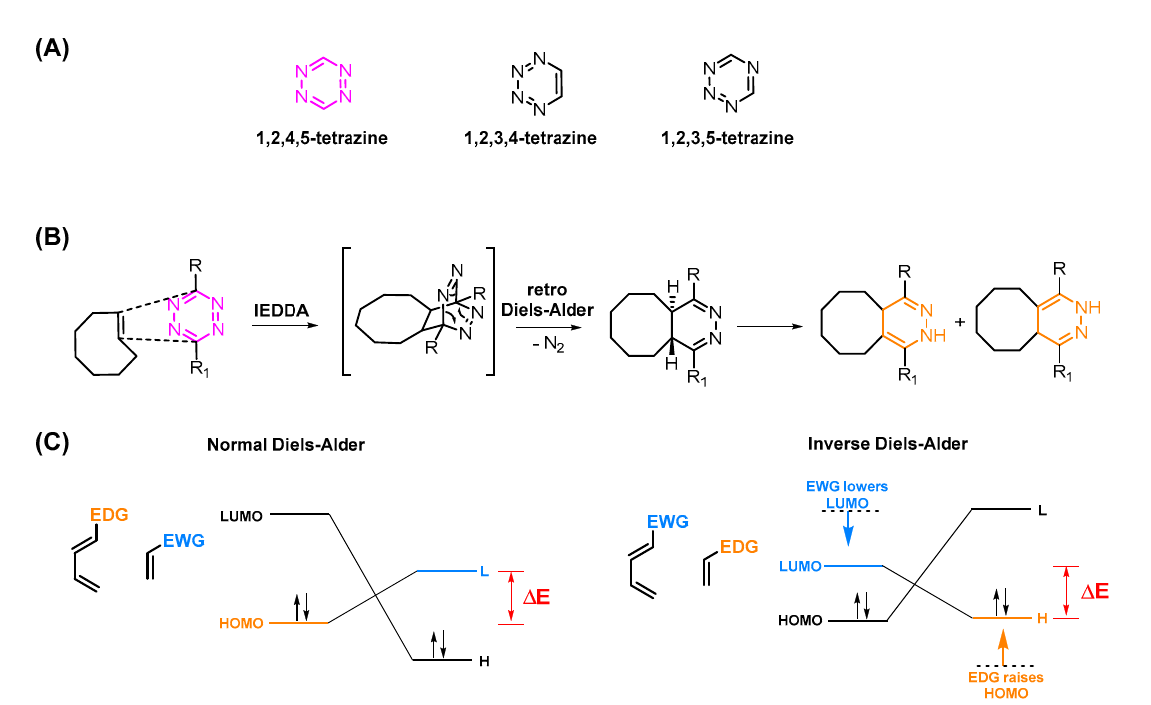
Figure 2. ( A ) Tetrazine isomers. ( B ) Mechanism of the Tz ligation, consisting of an inverse electron- demand Diels–Alder[4 + 2] cycloaddition (IEDDA) between a tetrazine (Tz) and a trans-cyclooctene (TCO) derivative, followed by a retro-Diels–Alder reaction (retro-DA) and N 2 elimination. ( C ) Frontier orbital model of the Diels–Alder reaction and the IEDDA reaction. EDG: electron donating group, EWG: electron withdrawing group, HOMO: highest occupied molecular orbital, LUMO: lowest unoccupied molecular orbital. By electronically tuning IEDDA derivatives, it is possible to manipulate the LUMO Diene –HOMO Dienophile energy gap ( Δ E) and accelerate the IEDDA. For the diene pair, electron deficiency derivatives decrease the energy of the LUMO Diene ; as for the dienophile, electron-rich derivatives increase the energy of the HOMO Dienophile .